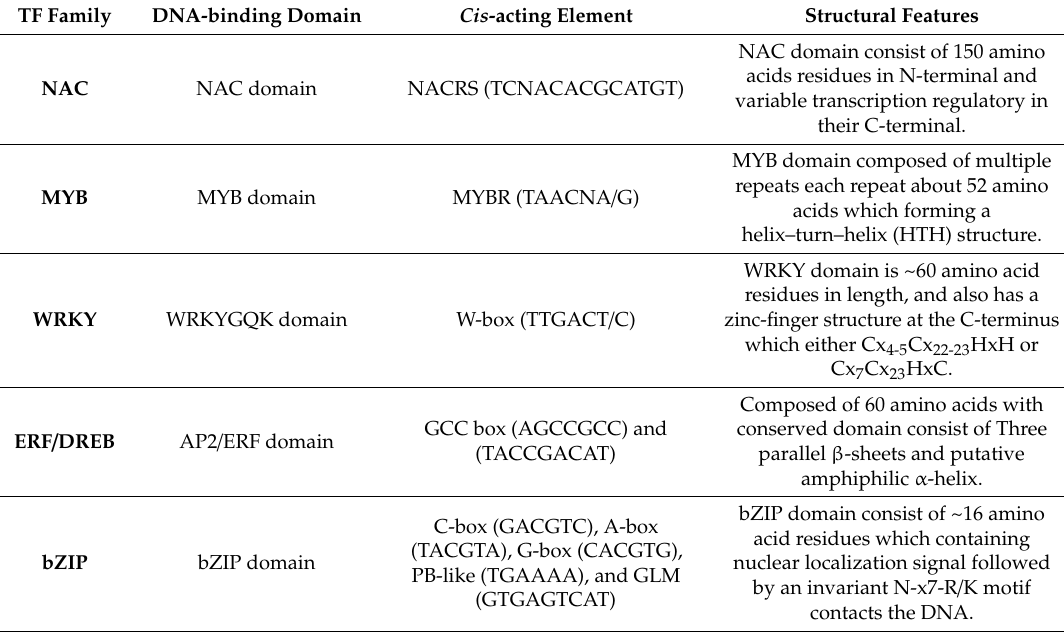
Figure 1. Pie chart showing the number of transcription factor (TF) genes in NAC, MYB, ERF, bZIP, WRKY, and other families in sorghum. Table 2. General features of the discussed transcription factor (TF)